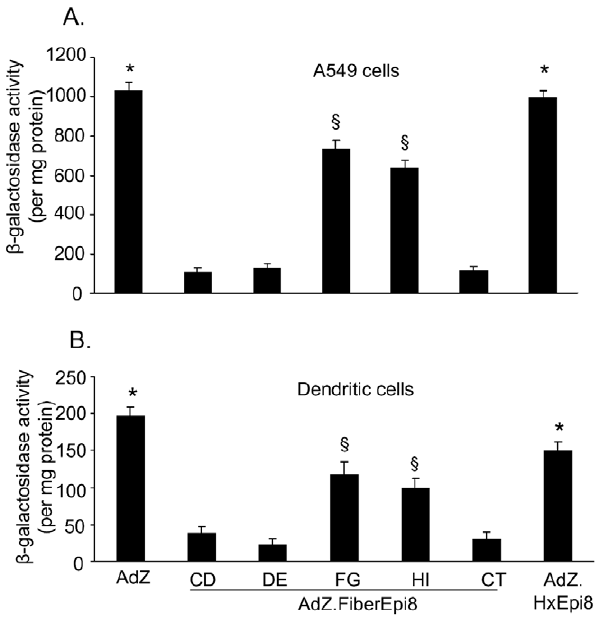
Figure 3. Infectivity of fiber-modified Ad vectors invitro . A549 cells (A) or murine bone-marrow-derived DC (B) were infected with the fiber-modified Ad vectors AdZ.F(CD)Epi8, AdZ.F(DE)Epi8, AdZ.F(FG)Epi8, AdZ.F(HI)Epi8 and AdZ.F(CT)Epi8, the hexon-modified AdZ.HxEpi8 or AdZ as control at 10 3 pu/cell (A549 cells) or 5 6 10 4 pu/cell (DC). b - galactosidase activity was evaluated after 36 h by spectrophotometeric assay and normalized to uninfected cells. Results represent mean 6 SEM of three independent experiments. * denotes p , 0.05, AdZ or AdZ.HxEpi8 compared to all others. 1 denotes p , 0.05, AdZ.F(FG)Epi8 or AdZ.F(HI)Epi8 compared to AdZ.F(CD)Epi8, AdZ.F(DE)Epi8 or Ad- Z.F(CT)Epi8.